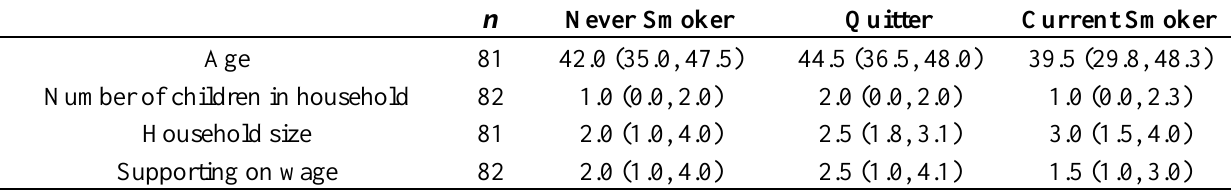
Table 1. Socio-demographic variables according to smoking status (median (IQR)) † .